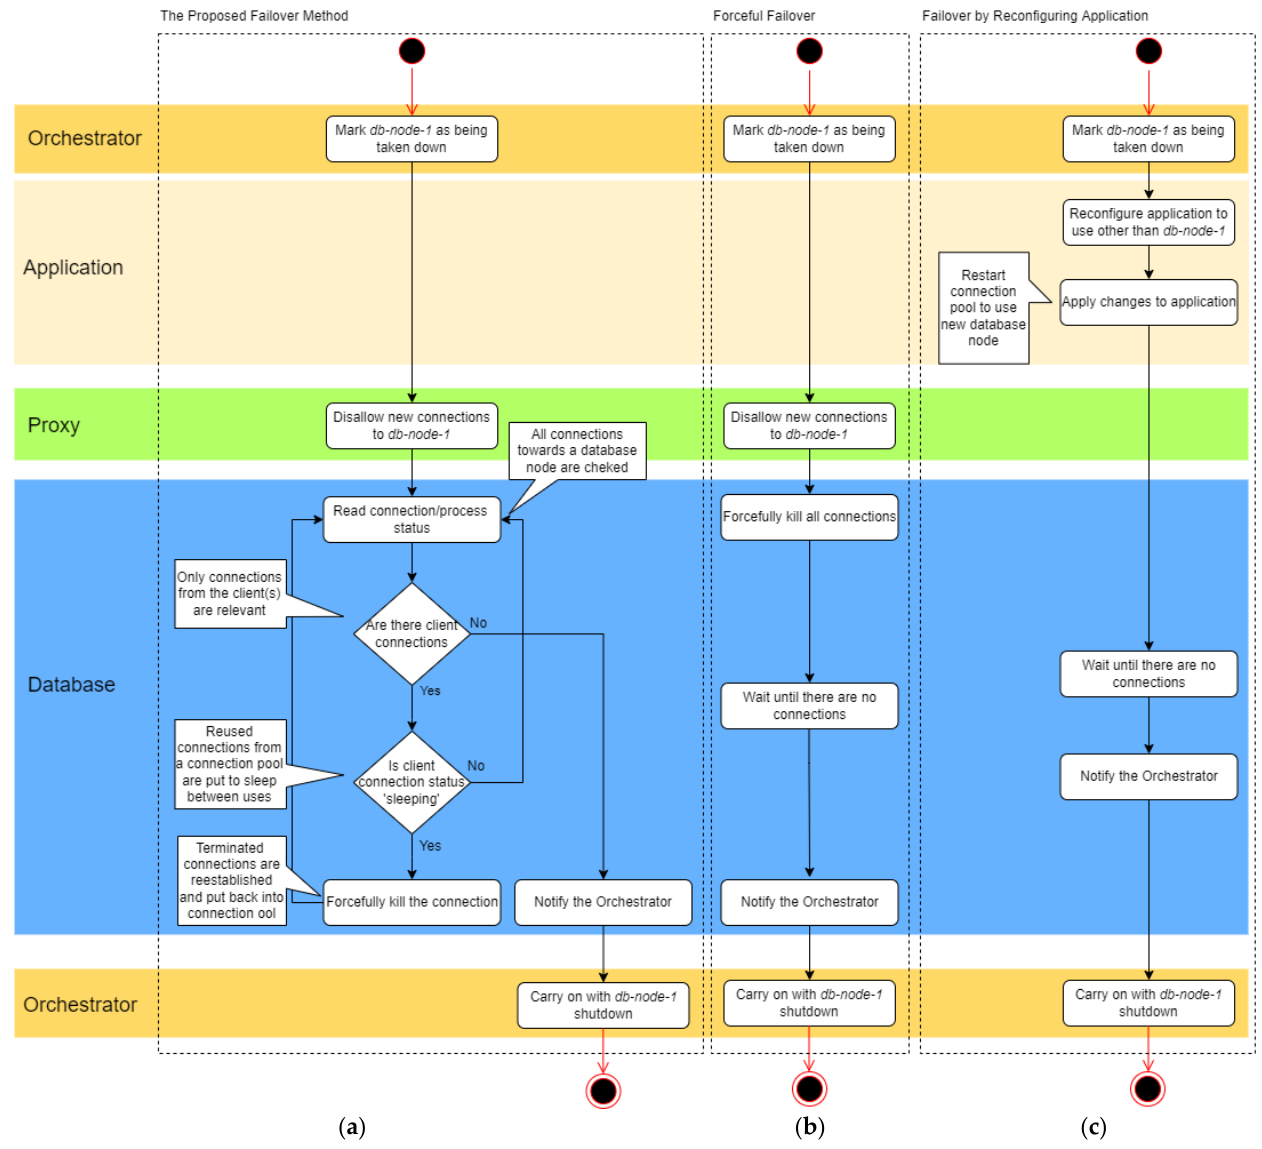
Figure 1. Flow diagrams of proposed graceful failover method ( a ) forceful failover ( b ), and failover requiring changes on application side ( c ).